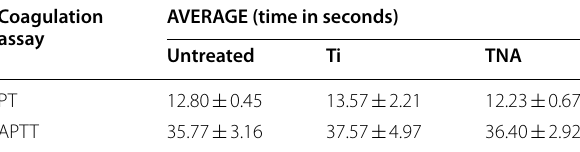
Results indicate mean values assays